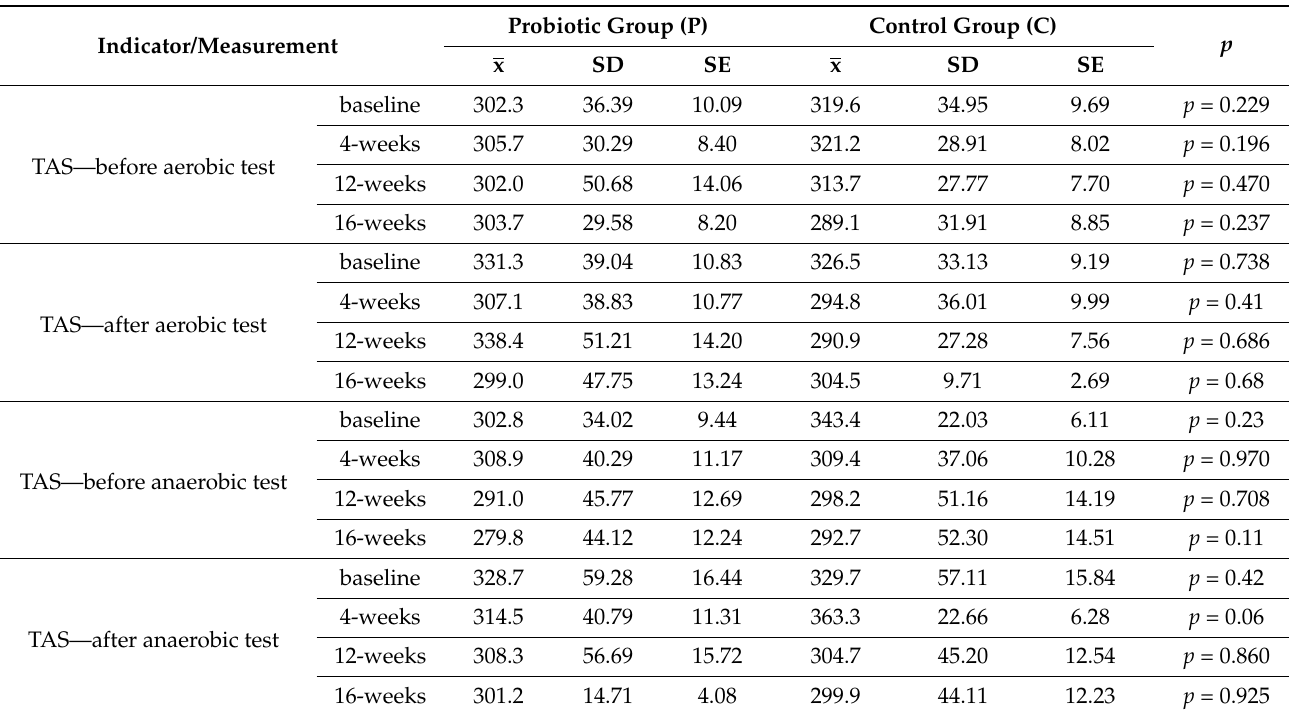
Table 14. Total anti-oxidant (TAS) status of the blood plasma pre- and post-aerobic test and pre- and post- anaerobic test at follow-up measurements during supplementation